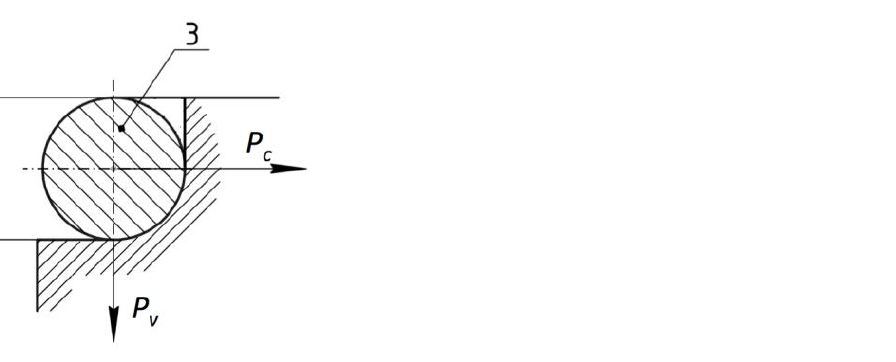
Figure 11. Schematic of the force components in the hole widened by a single calibrating insert.